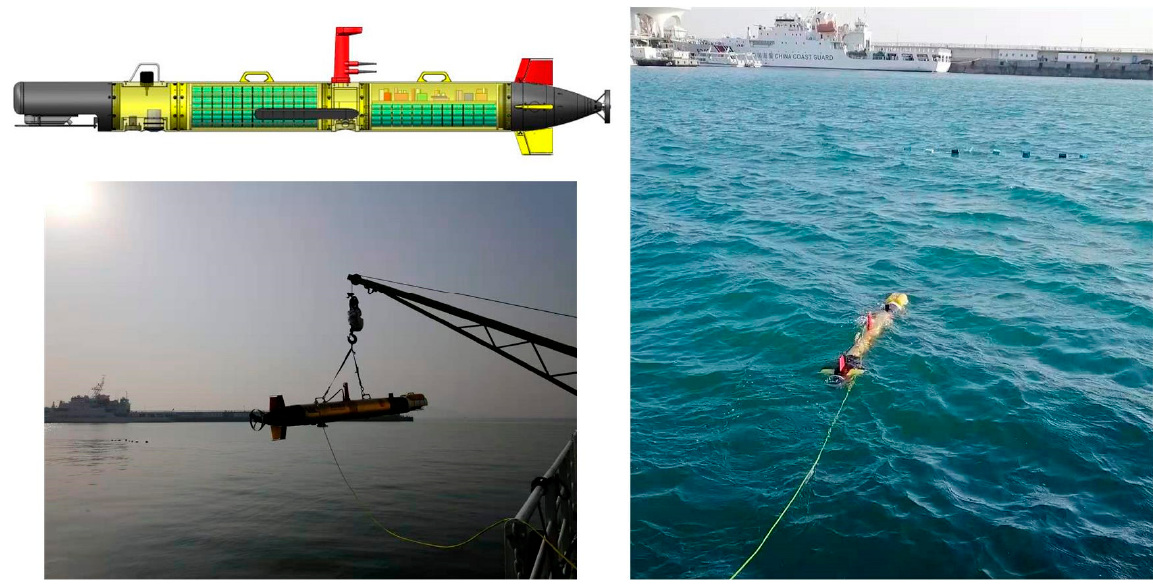
Figure 14. The structure of our autonomous underwater vehicle (AUV) platform and the scenes of the fishing net avoidance experiment.